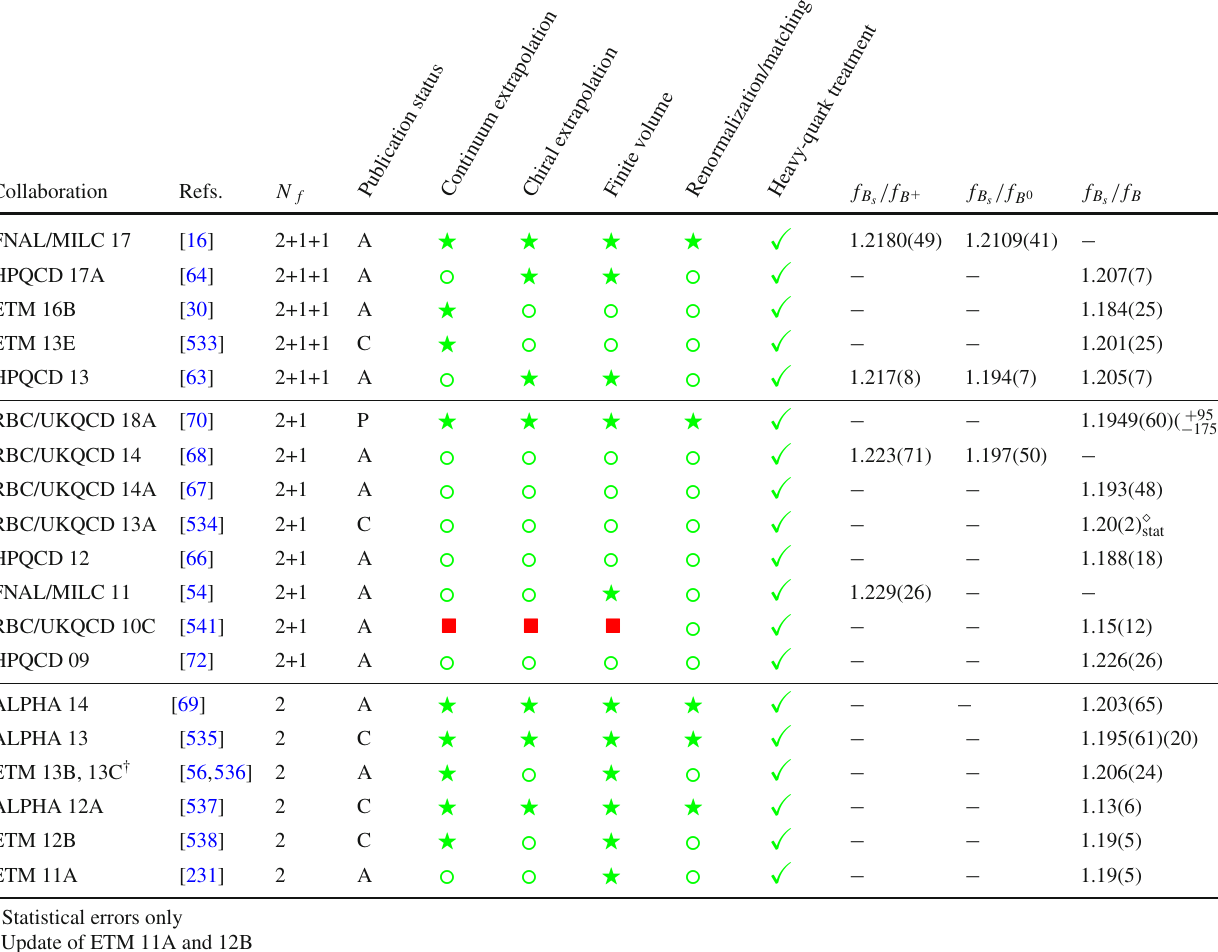
Table 42 Ratios of decay constants of the B and B s mesons (for details see Table 41)